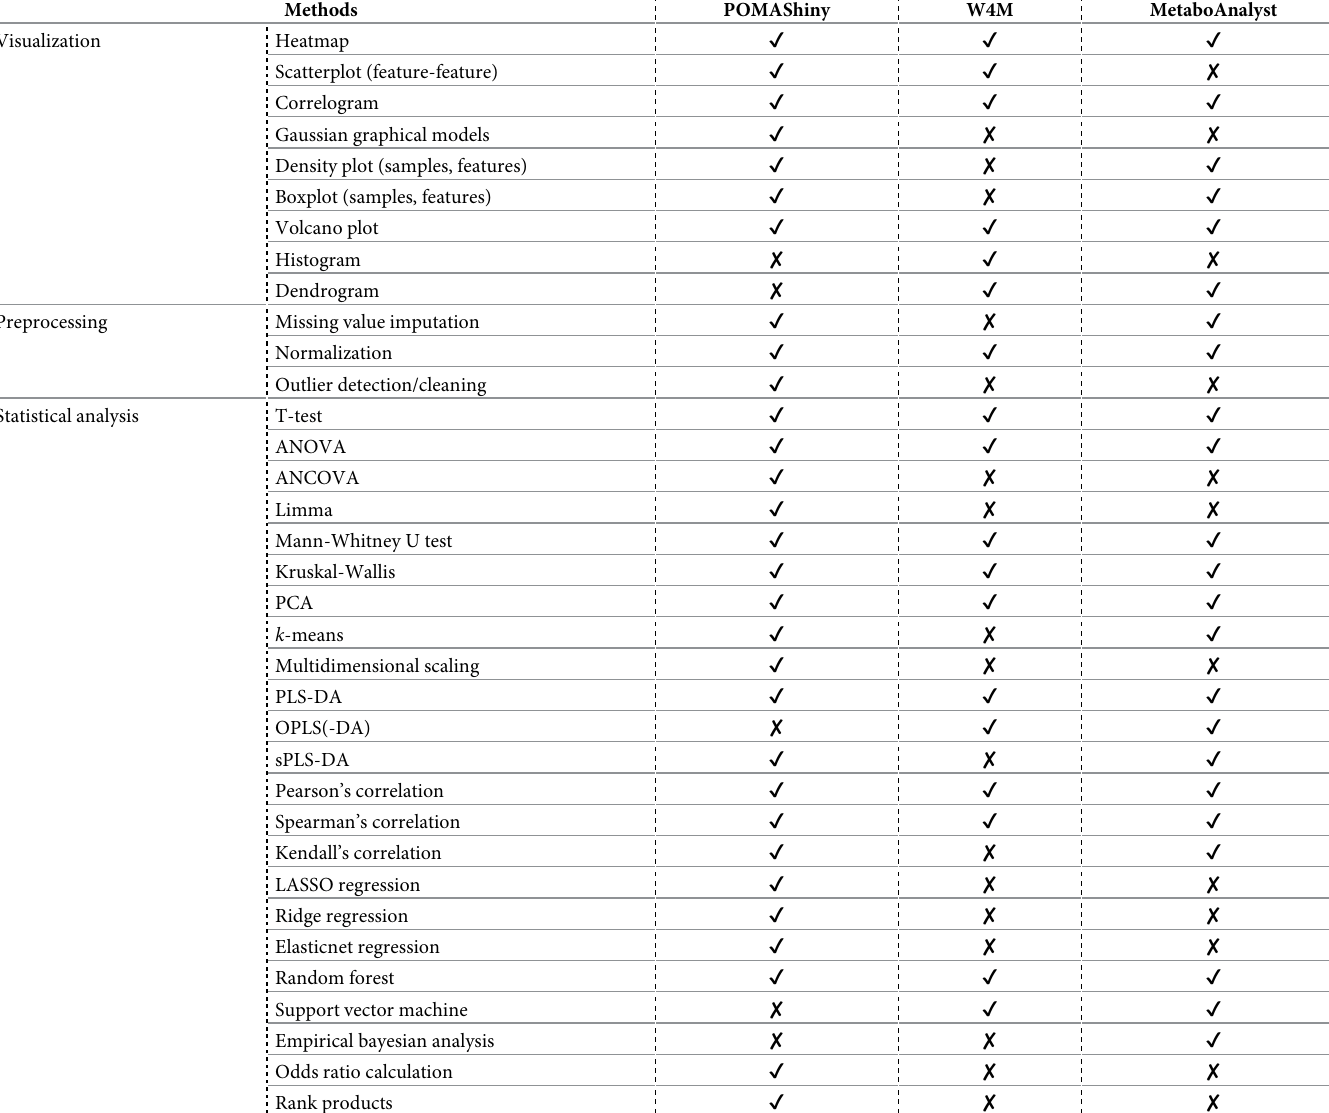
Table 2. Comparison of the main features of POMAShiny with Workflow4Metabolomics (W4M) and MetaboAnalyst web-based tools. Symbols used for feature eval- uations with “ ✔ ” for present and “ ✘ ” for